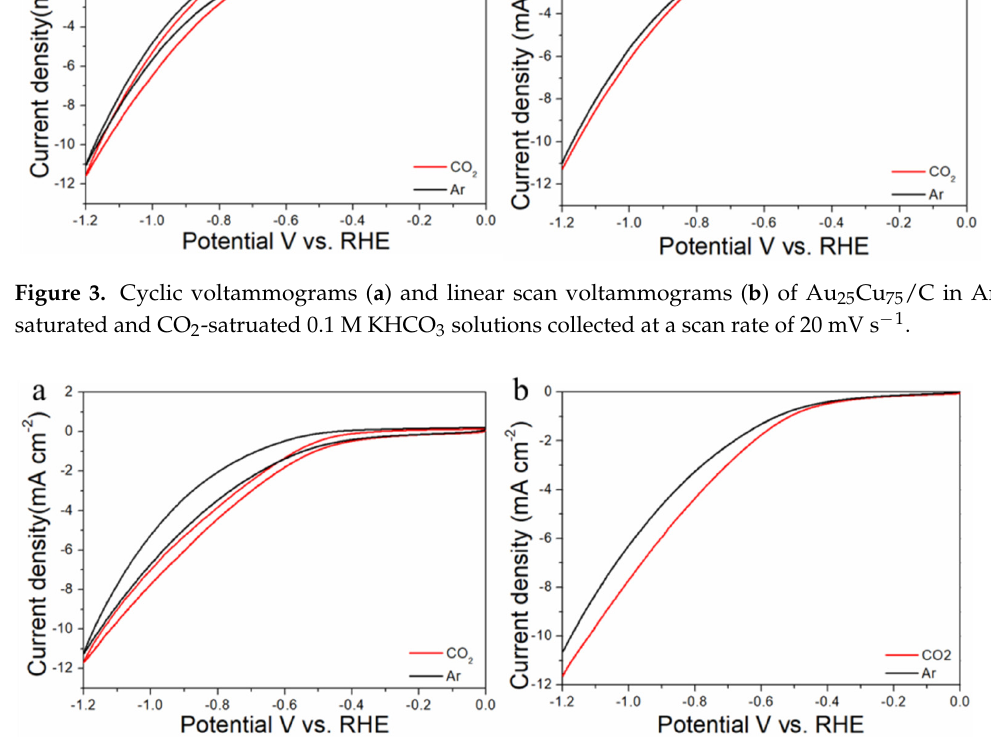
Figure 4. Cyclic voltammograms ( a ) and linear scan voltammograms ( b ) of Au 50 Cu 50 /C in Ar saturated and CO 2 -satruated 0.1 M KHCO 3 solutions collected at a scan rate of 20 mV s − 1 .